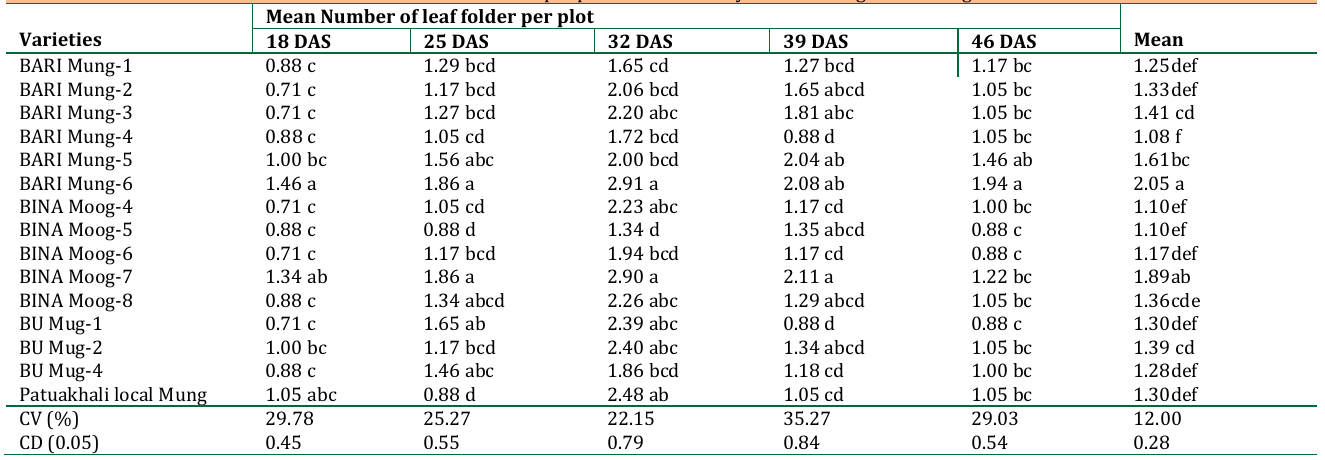
Table 1: Mean number of leaf folder per plot at different days after sowing on 15 mungbean varieties Mean Number of leaf folder per Varieties